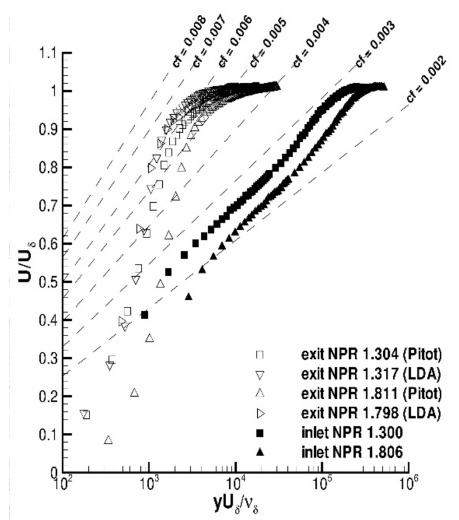
Figure 10. LU60 nozzle inlet and exit Clauser plots (probe and LDA data).